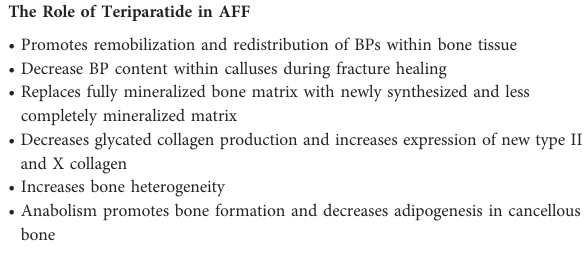
Table 1 details how BP treatment predisposes to AFFs development. Due to the high af fi nity of BP to HAP binding and long-term effects on bone resorption, a marked decrease in bone remodeling delays prompt micro-fracture healing (31). As micro-fractures accumulate, a greater stress reaction